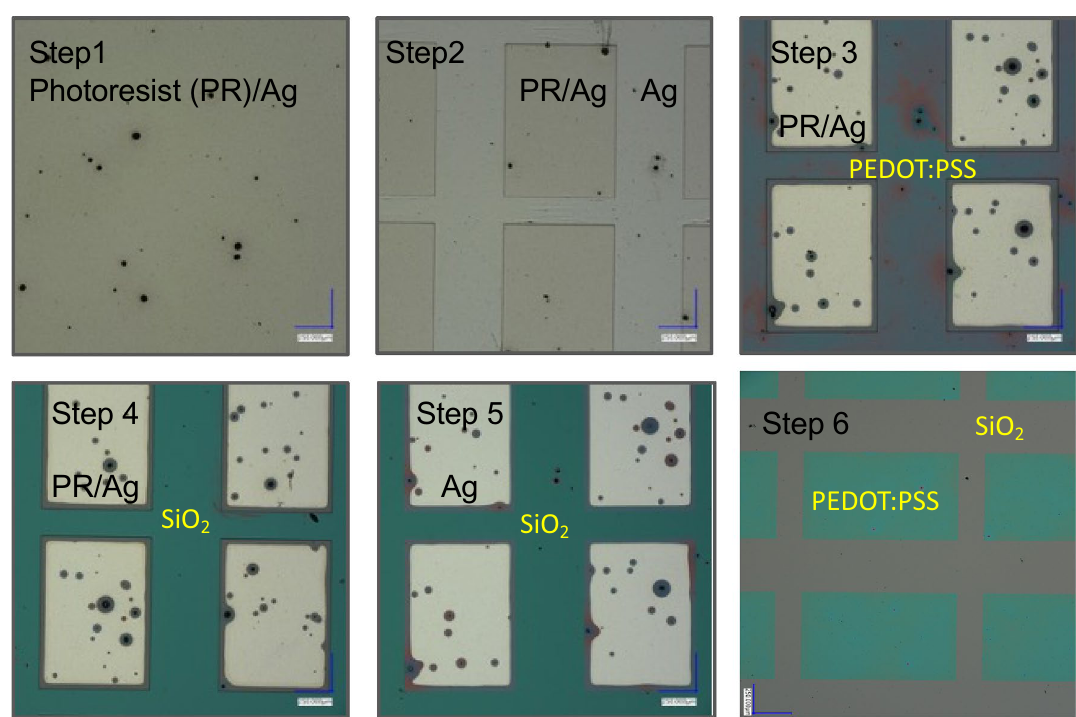
Figure 2. Optical pictures of the patterning process of PEDOT:PSS on an oxidized Si wafer. The six steps correspond to the six steps of the photolithography process flow shown in Fig.